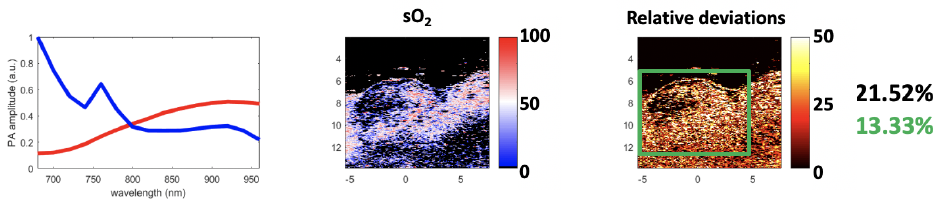
Figure 16. Results using the theoretical absorbance spectra of Hb and HbO 2 . ( a ) The theoretical spectra (mean values of Hb and HbO 2 are: 0.43 and 0.35, respectively), ( b ) sO 2 map estimated using the FCLS with the theoretical spectra and Equation (16), and ( c ) the relative deviation maps between the sO 2 map and the Vevo LAZR map in Figure 12. The image axes are in